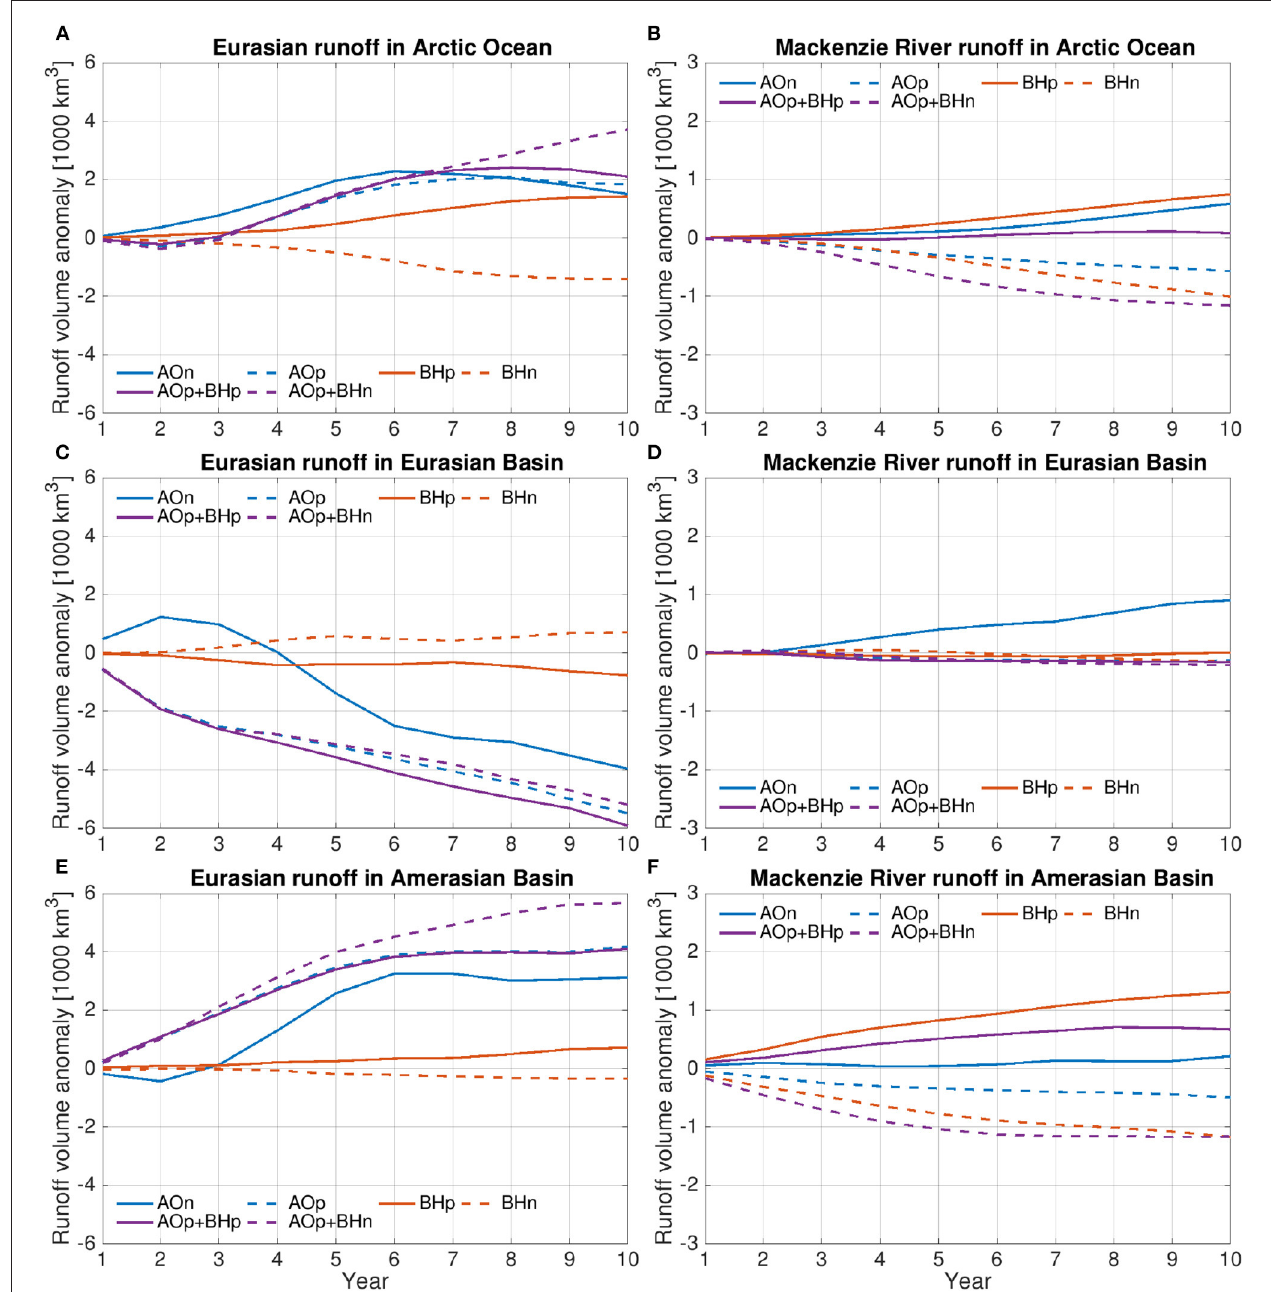
FIGURE 10 | Time series of the volume of the (A) Eurasian runoff and (B) Mackenzie River runoff in the Arctic Ocean. The anomalies relative to the control run are shown. (C,D) The same as (A,B) , but for the anomalies in the Eurasian Basin. (E,F) The same as (A,B) , but for the anomalies in the Amerasian Basin. Note that different y-axis scales are used in the left and right columns.